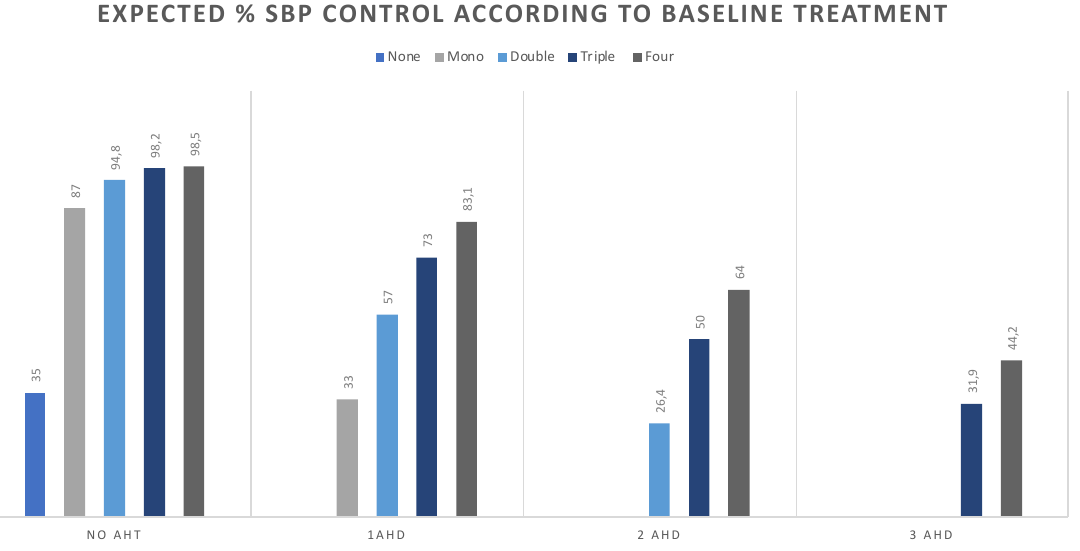
Figure 4. Baseline and expected relative change in SBP control according to current and escalated therapy. AHT, antihypertensive therapy; AHD, antihypertensive drugs; SBP, systolic blood pressure. The expected change in A1c control was assessed in 752 participants. The percentage of individuals with controlled A1c was 51% for monotherapy, 34% for dual therapy, 34% for triple, and 23% for insulin users. Among ADT monotherapy users, initiation of double, triple, and four drugs would increase A1c control to 66% ( p = 0.031), 75% ( p < 0.001), and 79% ( p < 0.001), respectively. Similarly, escalating from double to triple therapy would